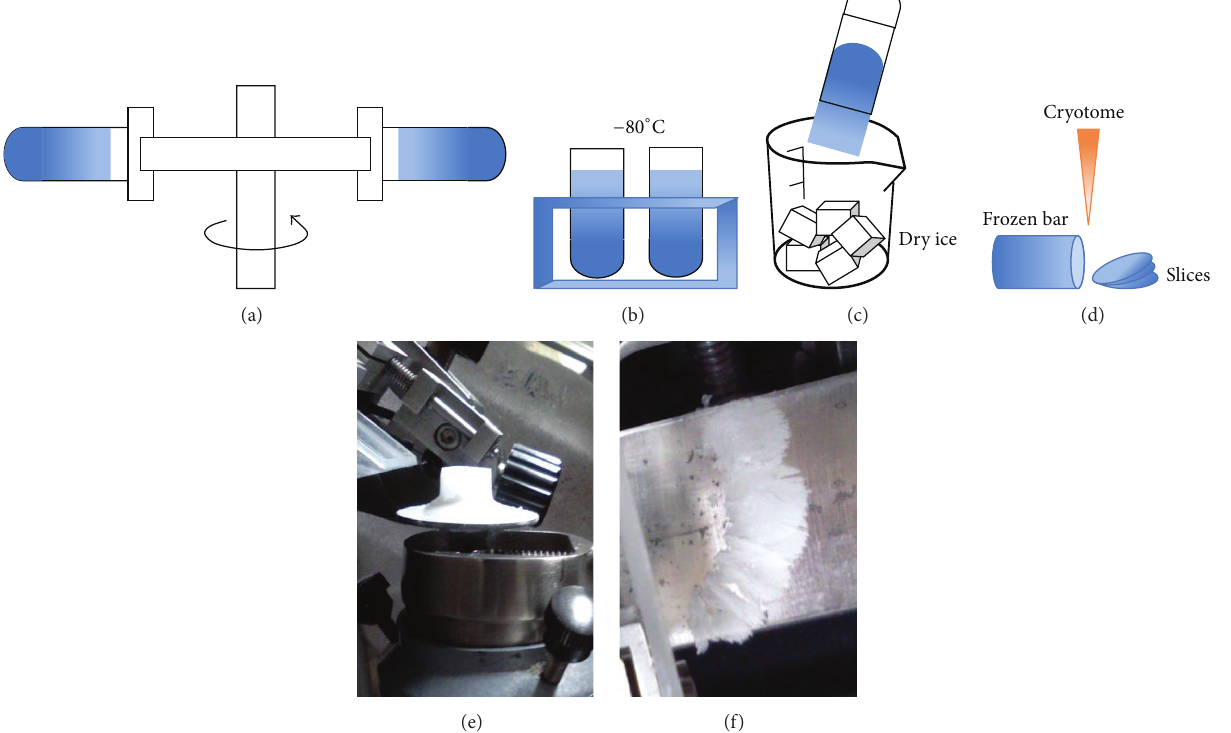
Figure 1: Major steps for F-S method. (a) Sample being centrifuged at 40000 rpm. (b) Gradient sucrose solution being frozen at − 80 ∘ C; (c) ice bar being unloaded from centrifuge tube into dry ice. (d) Frozen bar being sliced. (e) Frozen bar fixed on stage. (f) Status and shape of freshly sliced ice